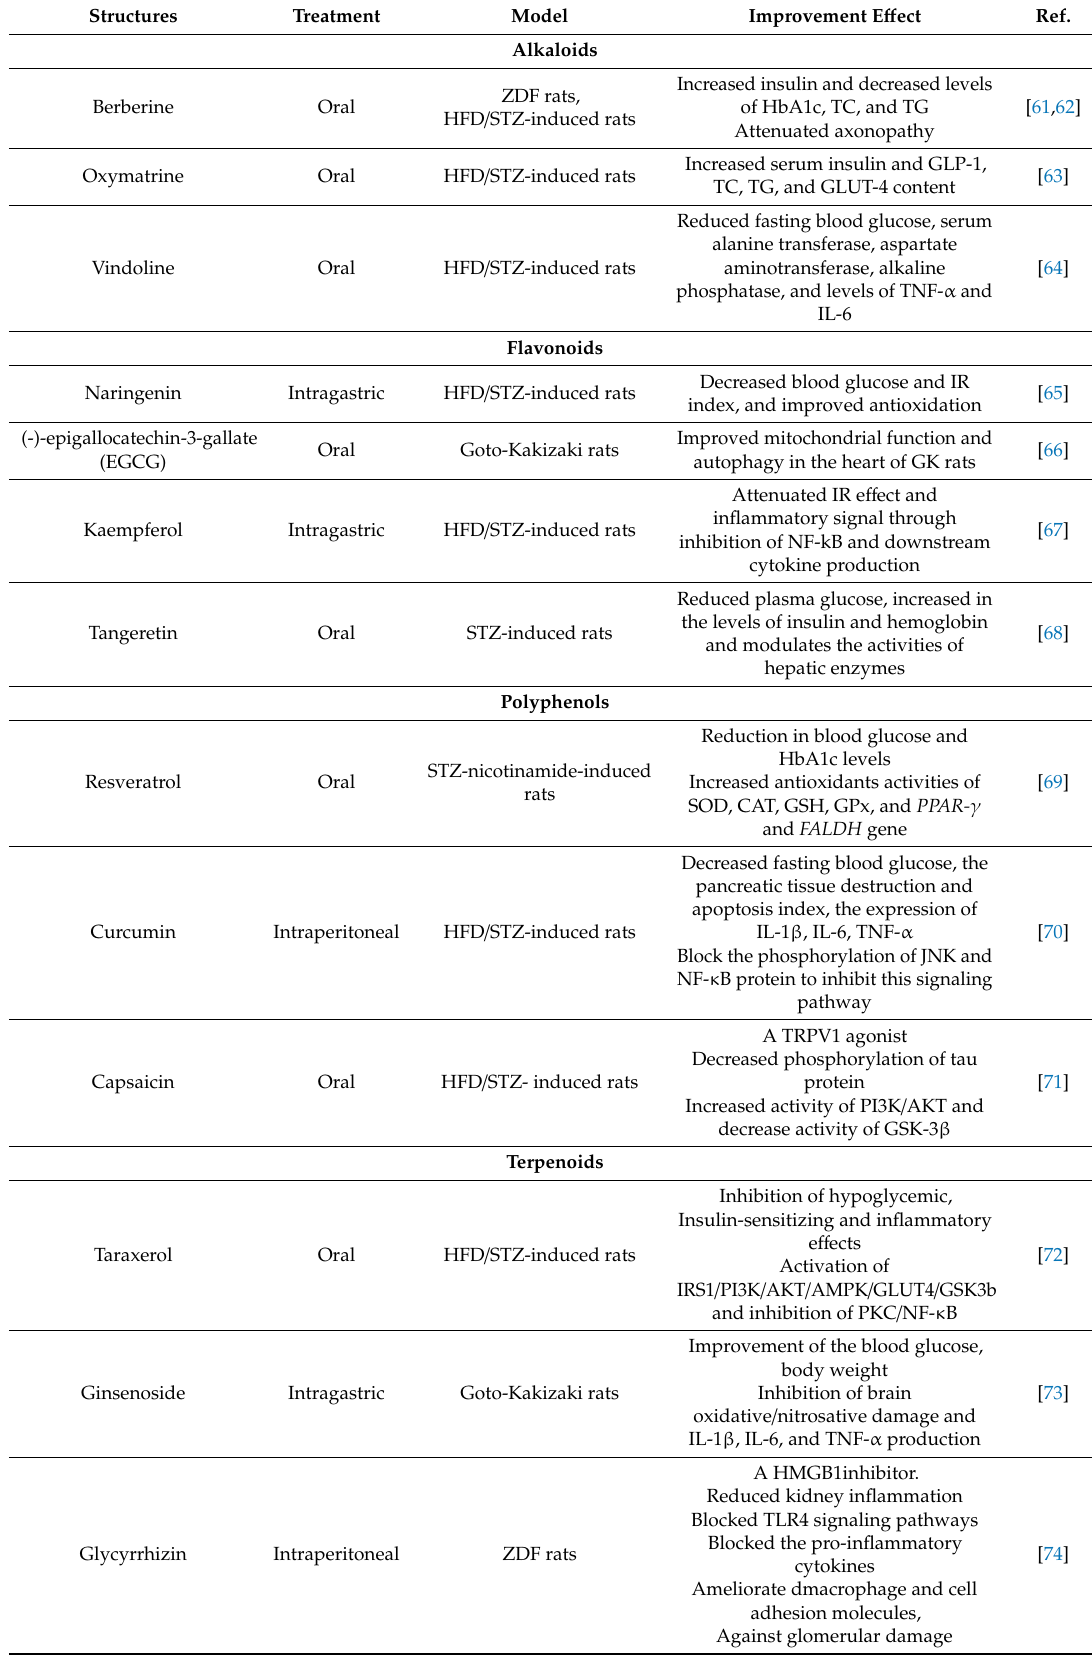
Table 3. Natural bioactive compounds for the treatment of rat models of